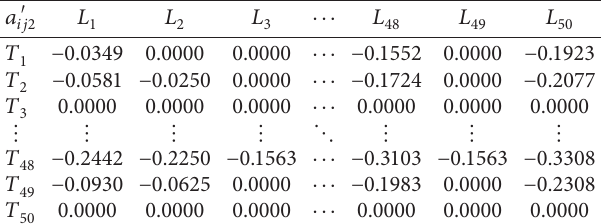
Table 15: Perceived utility matrix V s ′ � [ a ij ′ ] for 2 2 50 × 50 housing rent.